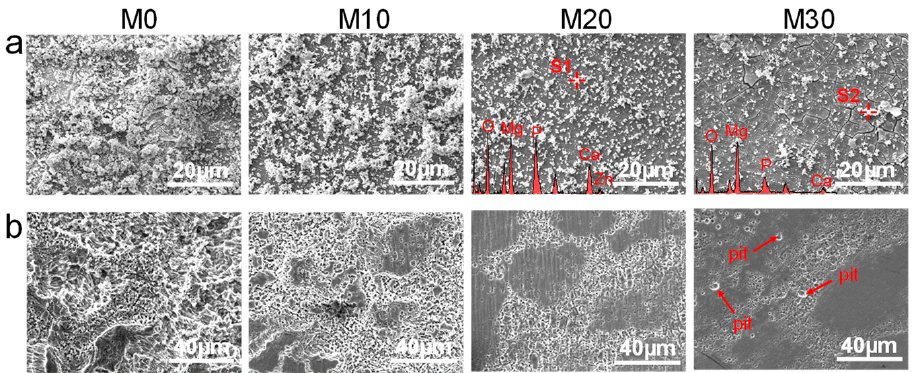
Figure 8. Surface morphologies of laser-sintered parts: ( a ) before and ( b ) after removing corrosion products.